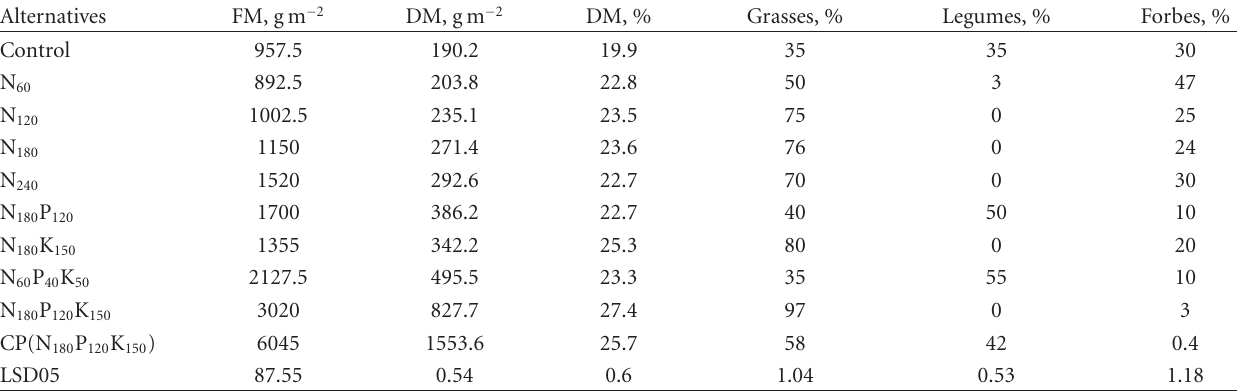
Table 2: Grasslands productivity and botanical composition response to applied fertilizing and farming management (FM-fresh mass; DM- dry materials).